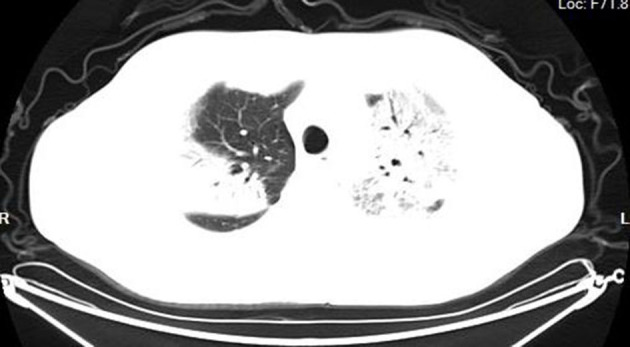
Ground-glass opacity, patchy shadow, and consolidation shadow in both lungs.